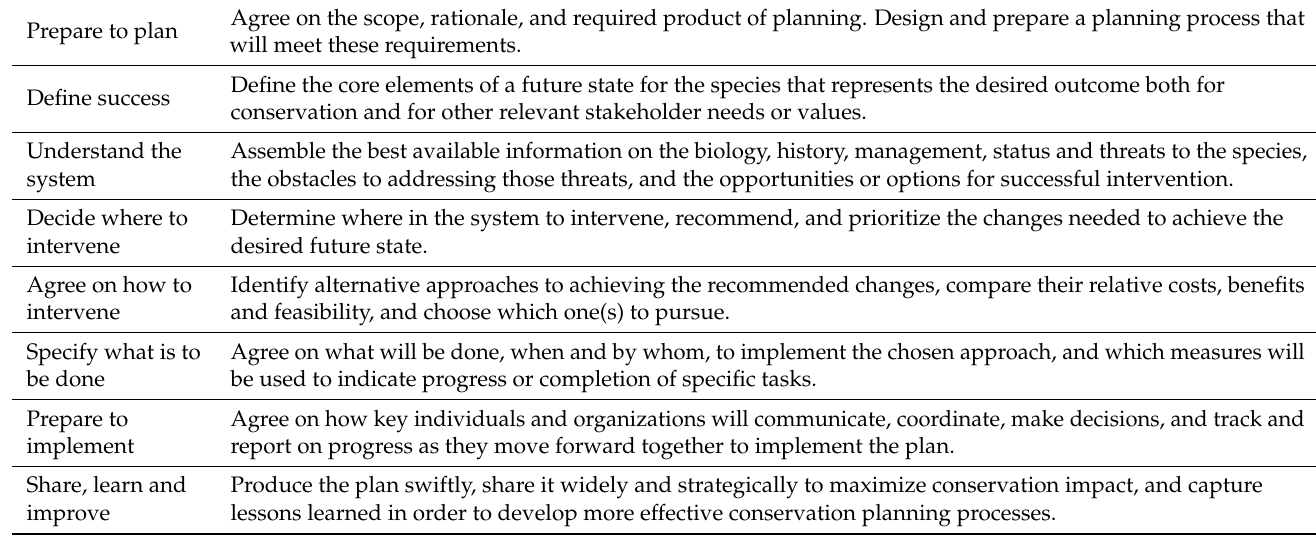
Table 2. SSC CPSG Species Conservation Planning